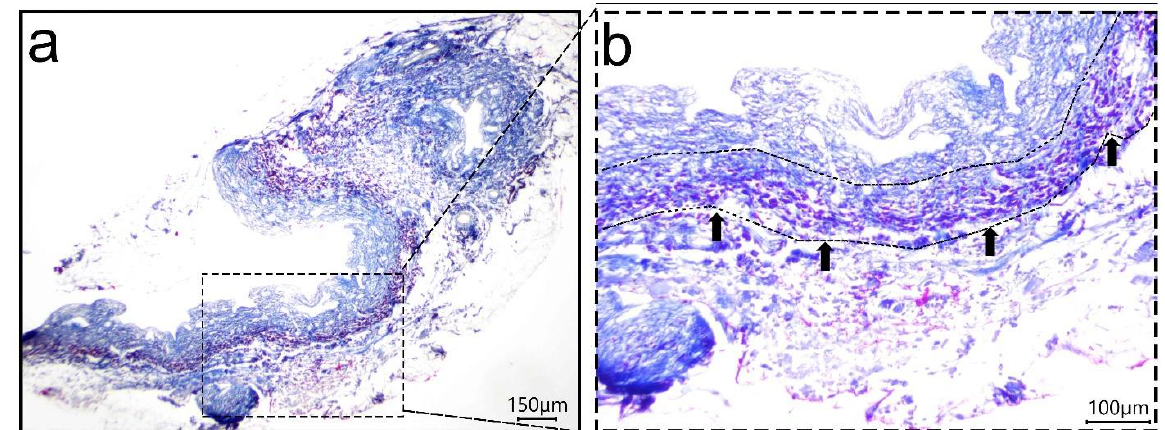
Figure 5. Cell infiltration of the dECM-BD 7 days post seeding. Masson's trichrome stain after 7 days of cell seeding in the dECM-BD ( a ), and the arrows in the magnification show the infiltration of cells in the decellularized matrix ( b ). (Luminal side is in the upper side of the images).